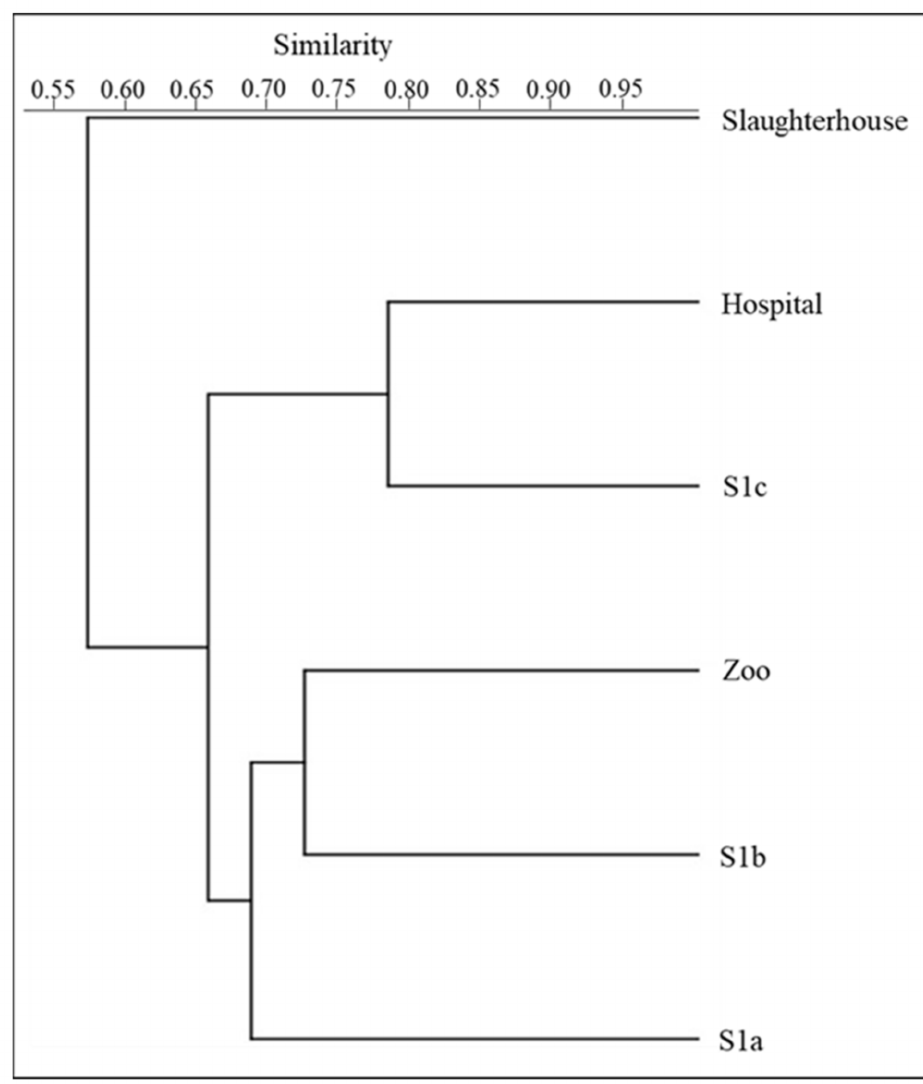
Figure 2. Bray-Curtis distance constructed by PAST software for clustering of sampling sites based on the phyla